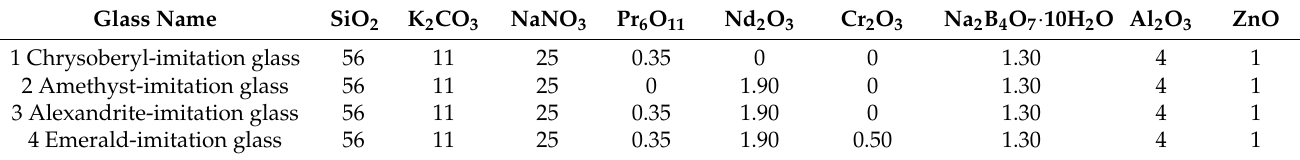
Table 1. Ratio of raw materials to 4 types of imitation gemstone glass (Unit: mol%).